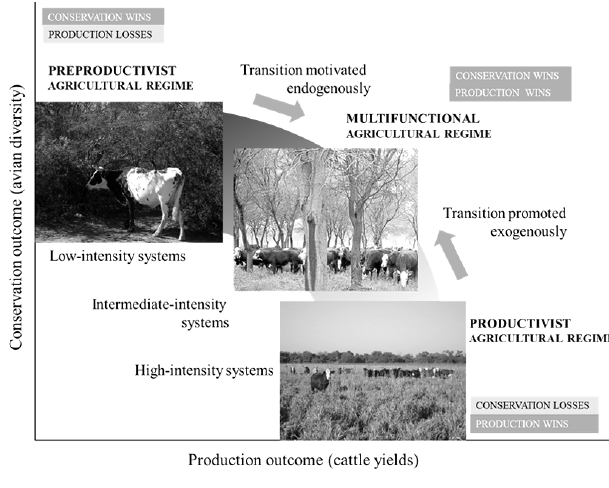
Fig. 3 . Social-ecological trade-offs and desired transitions between agricultural regimes in Dry Chaco agricultural frontiers. Multifunctional agricultural regimes simultaneously provide high conservation and high production outcomes. A transition from preproductivist to multifunctional regimes is motivated endogenously because of the willingness of preproductivist landholders to intensify some portions of their landholdings. In contrast, a transition from productivist to multifunctional regimes should be promoted exogenously through incentives and regulations as productivist landholders are not willing to conserve